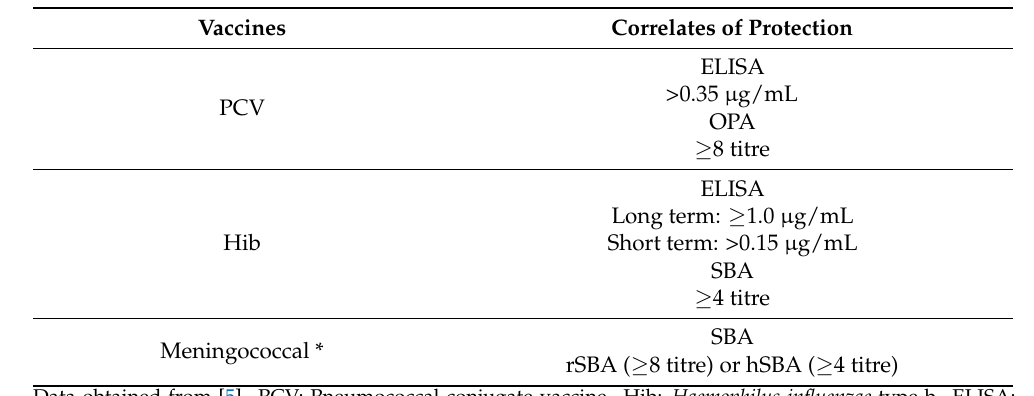
Table 2. Correlates of protection for pneumococcal, Hib and meningococcal